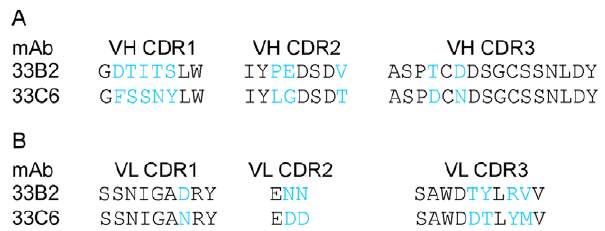
Figure 6. VH and VL CDR sequences of V3-specific mAbs. (A) 33B2 and 33C6 VH CDR amino acid sequences. (B) 33B2 and 33C6 VL